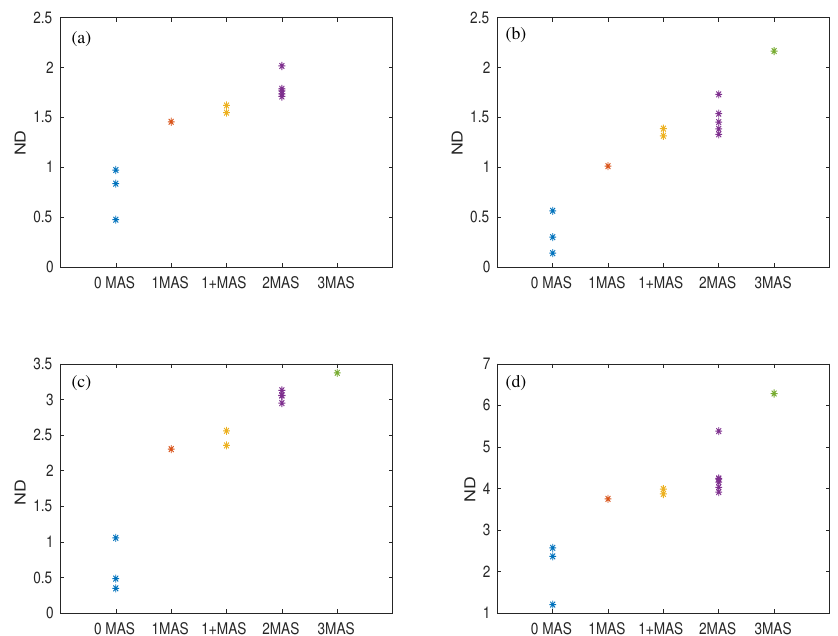
Figure 6. Variation of Norm Distance (ND) with respect to MAS level for four muscles activity converted from EMG signal. ( a ) for M. rectus femoris, ( b ) for M. biceps femoris, ( c ) for M. tibialis anterior and ( d ) for M. gastrocnemius. The number of data points changes for different panels because EMG signals collected from some muscles had poor quality and had to be discarded from